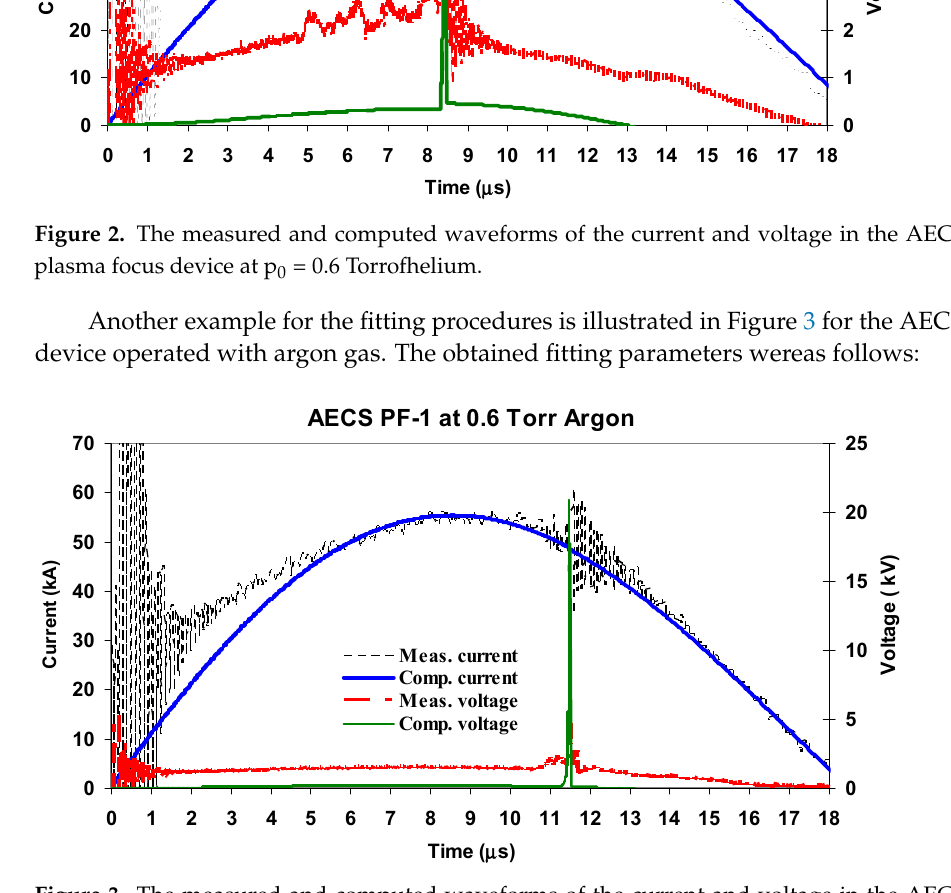
Figure 2. The measured and computed waveforms of the current and voltage in the AECS PF-1